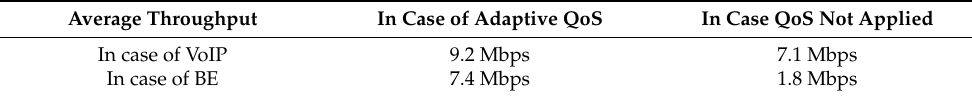
Table 8. Scenario 1 Throughtput Results.